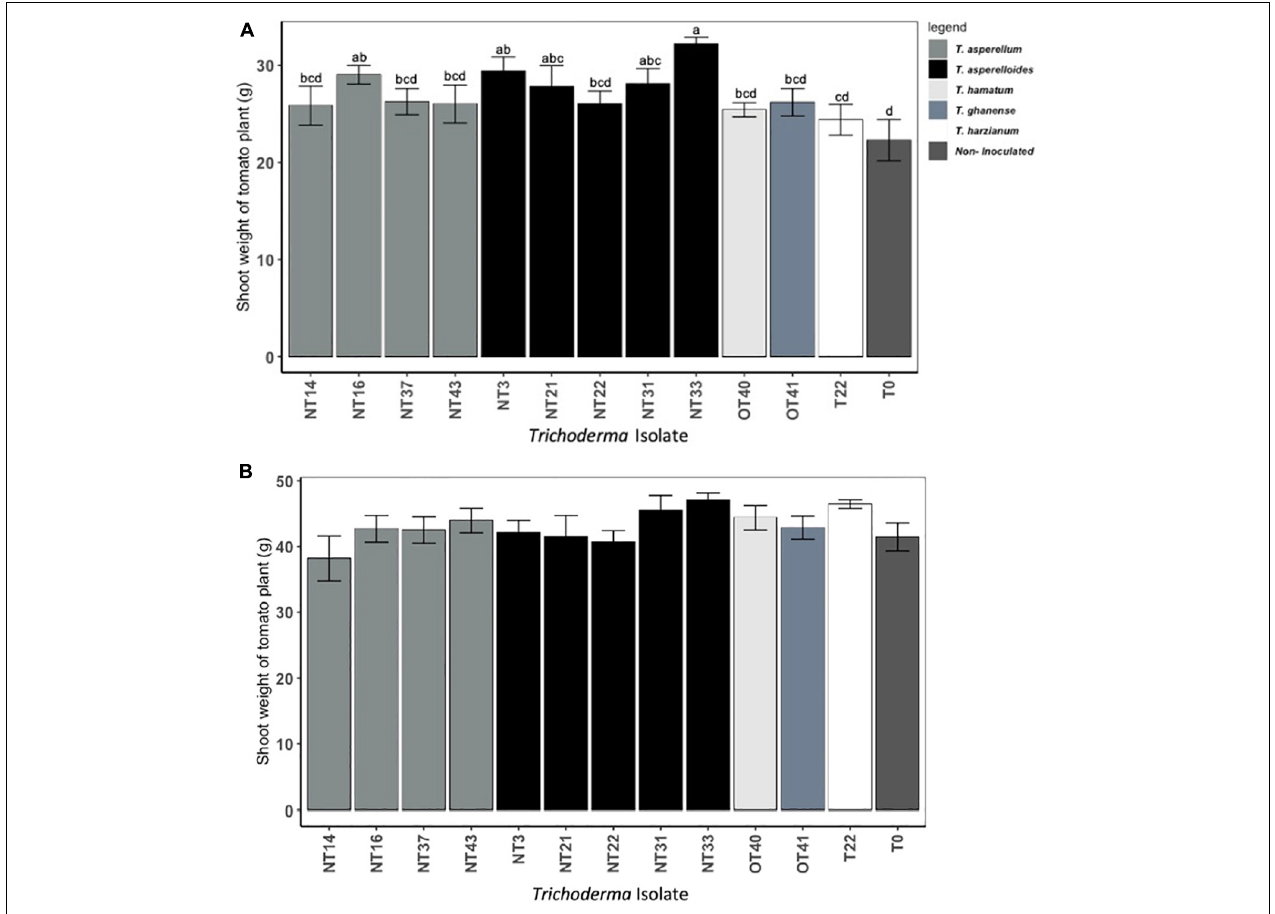
FIGURE 3 | Effect of Trichoderma isolates on shoot weight of Roma tomato subjected to: (A) water deficit stress, (B) continuous irrigated conditions. The water deficit stress was imposed by withholding the irrigation for 5 days. Thereafter, the stressed plants were irrigated again for a 7-day recovery period prior to harvest. The shoot fresh weights per plant were recorded. Values are means ± SE of three trials each with four replicates. Isolates with different superscripts are significantly different according to Fisher LSD test ( P < 0.05). Bar colors represent the species of tested